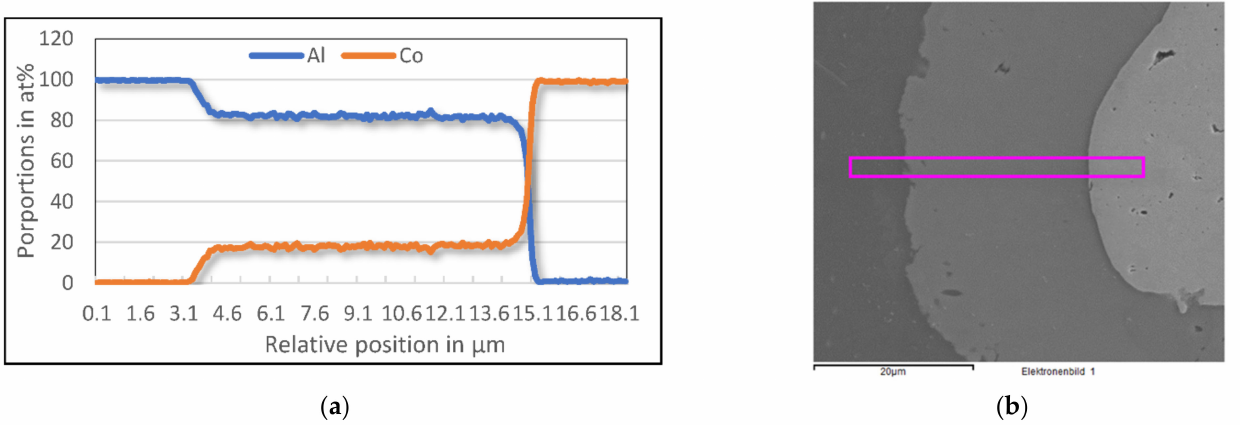
Figure 7. EDX analysis of the Al matrix with 10 mass-% Co: ( a ) EDX mapping showing the distribu- tion of the elemental composition over the selected range, see ( b ). EDX mapping indicates that a Co and Al phase has formed in the transition